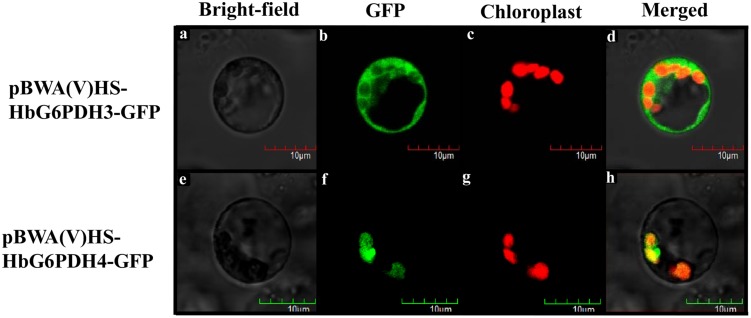
Localization of pCAMBIA1300-HbG6PDH3-GFP and pCAMBIA1300-HbG6PDH4-GFP in rice protoplasts. Scale bar = 10 μm. (a,e), bright field image; (b,f), transient expression of GFP; (c,g), chloroplast autofluorescence; (d,h), merged GFP and chloroplast image.